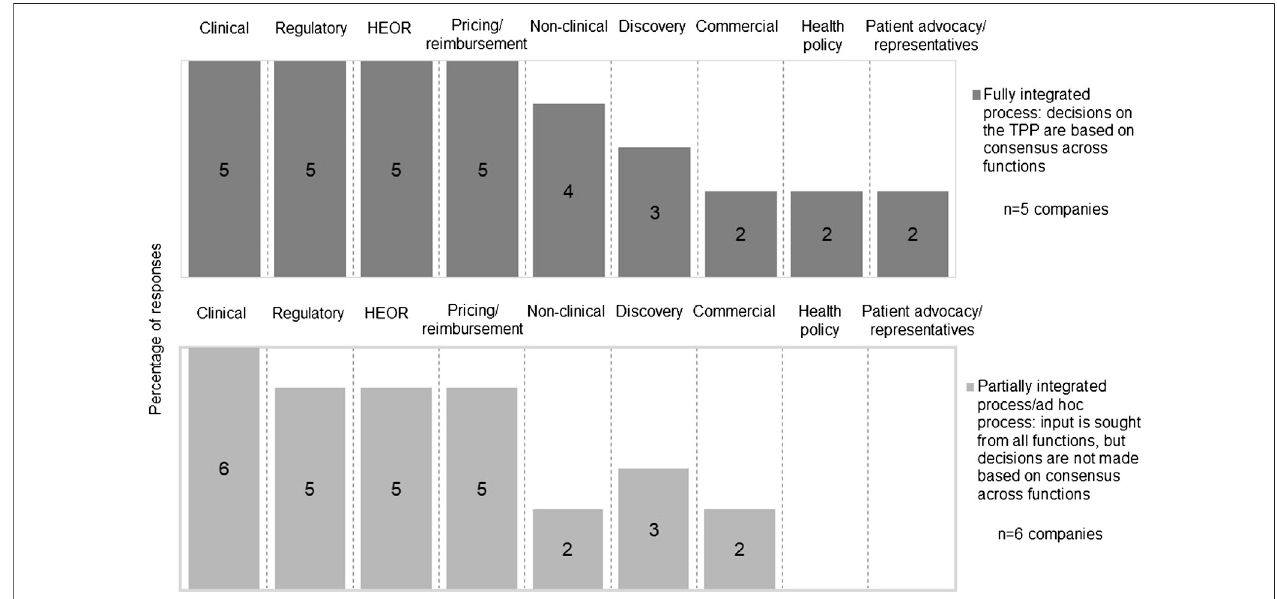
FIGURE 3 | Cross function involvement in the development of the TPP.